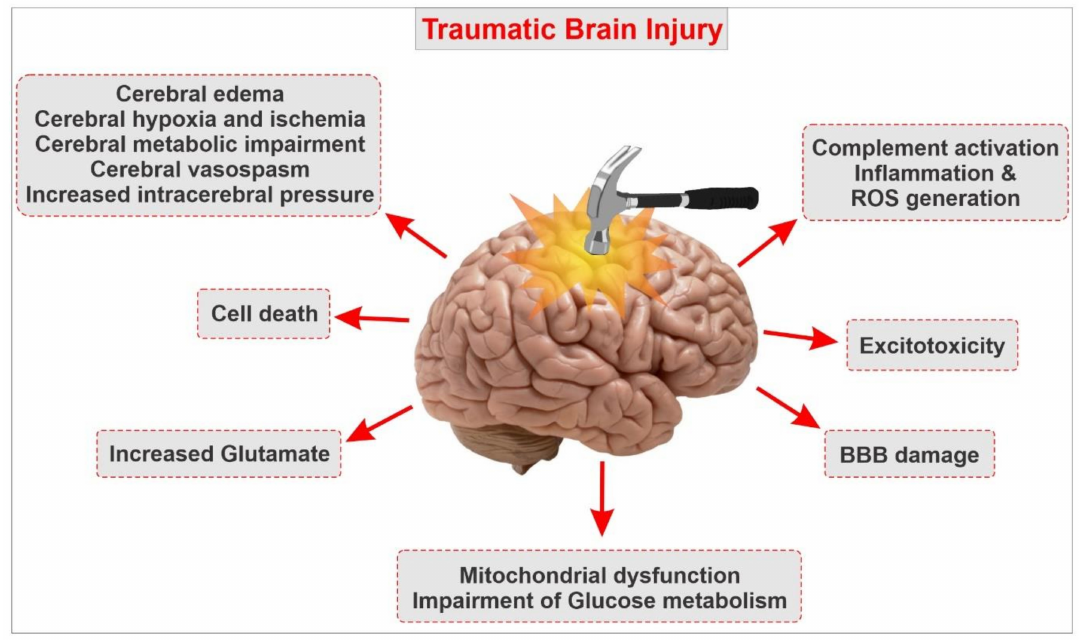
Figure 1. Simple schematic outlining the pathophysiological responses following traumatic brain injury and the complex outburst of secondary impairments. Note that secondary injury processes of traumatic brain injury (TBI) include blood–brain barrier (BBB) disruption, neuroinflammation, excitotoxicity, metabolic impairments, apoptosis, oxidative stress, ischemia, and others. Associated with BBB impairment, microglial and astrocyte activation, leukocyte infiltration, and upregulation of pro-inflammatory cytokines are characteristic of the neuroinflammatory response of